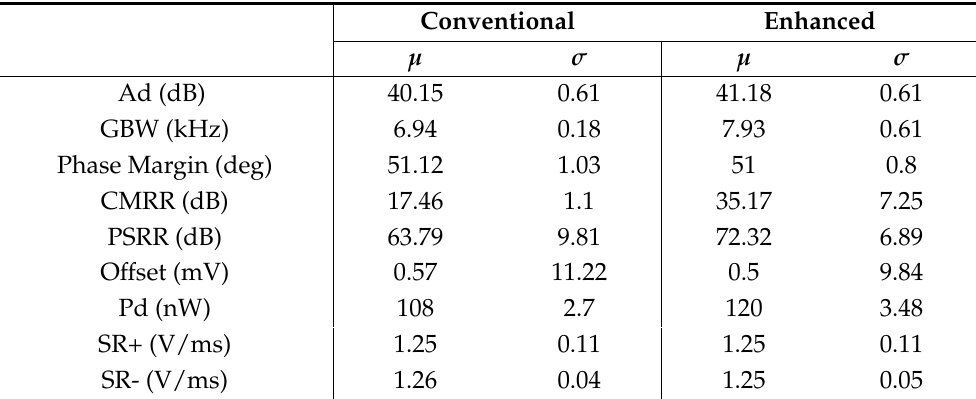
Table 4. OTA performance in Monte Carlo mismatch simulations.